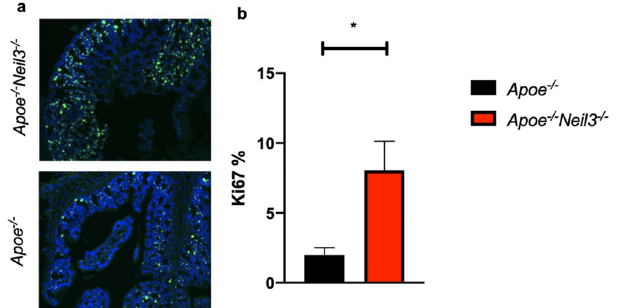
Figure 4. Increased expression of Ki67 in NEIL3-deficient colonic epithelial cells. ( a ) Representative immunohistochemistry images of large bowel sections from Apoe −/− Neil3 −/− and Apoe −/− mice stained with nuclei marker DAPI (blue) and proliferation marker anti-Ki67 (green). ( b ) Relative abundance of Ki67-positive cells. Data are presented as mean ± SEM, Student’s t test, * p < 0.05, n = 5.